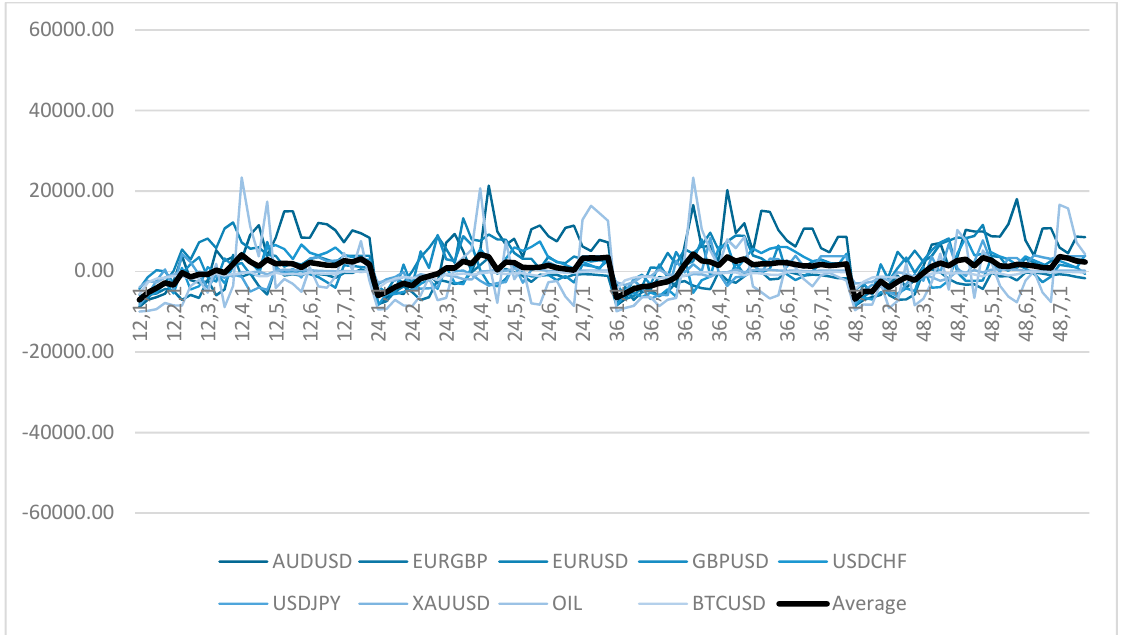
Figure 14. Net Profits of experiment (g) for various combinations of N, x , y .